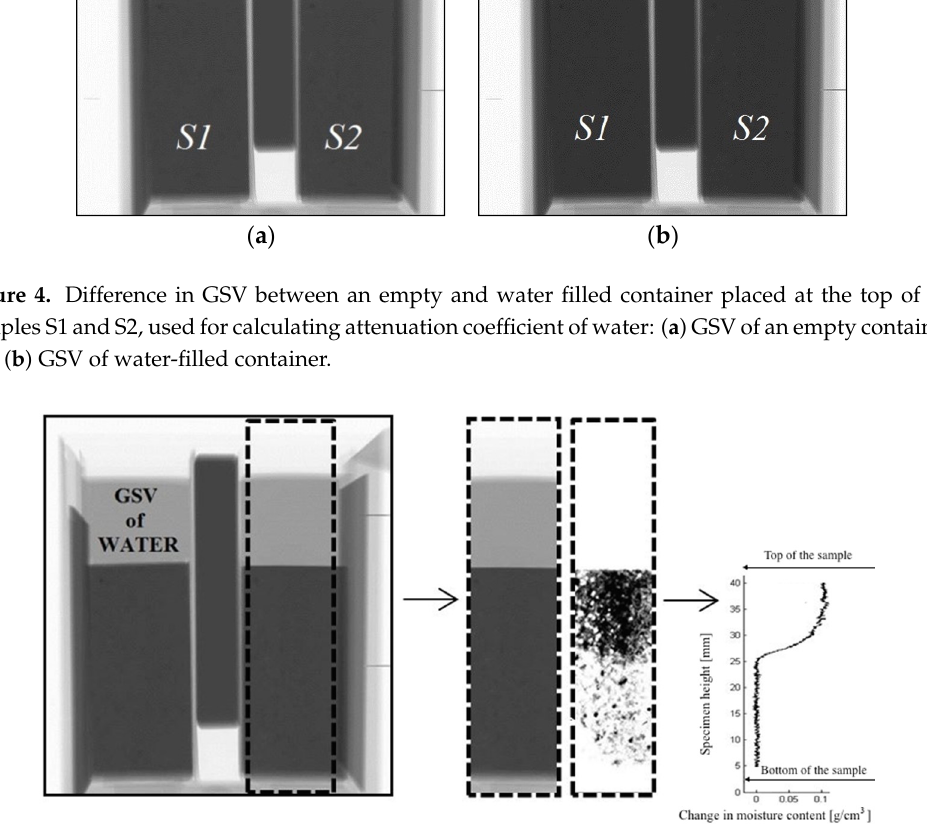
Figure 5. An example of the original X ‐ ray image and analyzed part of the specimen from which the moisture profile is calculated.